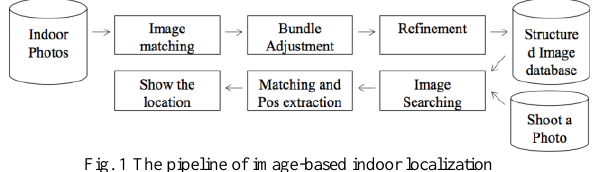
Fig. 1 The pipeline of image-based indoor localization